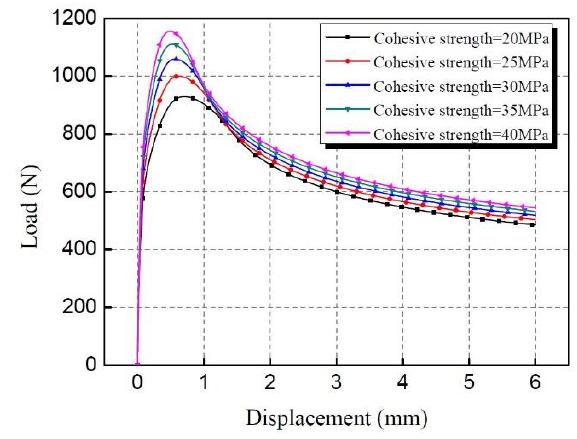
ff erent cohesive strength values. Figure 10. Load – displacement curves with different cohesive strength values. Figure 10. Load–displacement curves with di Table 6. Comparison of the maximum load and final load by the experiments and simulations.